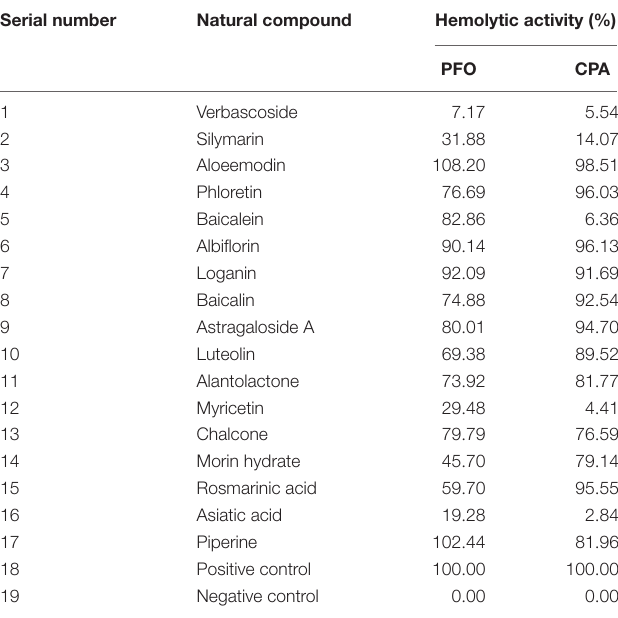
TABLE 1 | Natural compounds tested in this